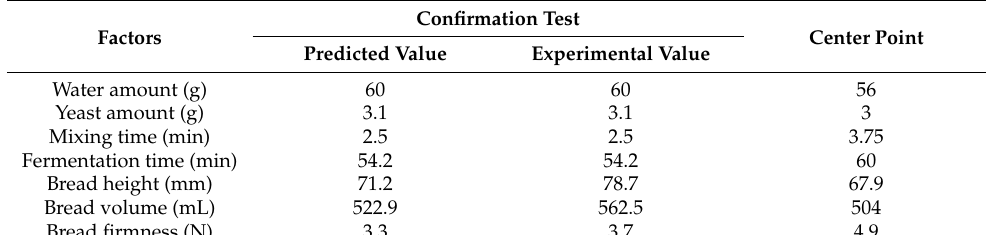
Table 6. Comparison of predicted, experimental actual, and center point values for confirming the optimized solution.